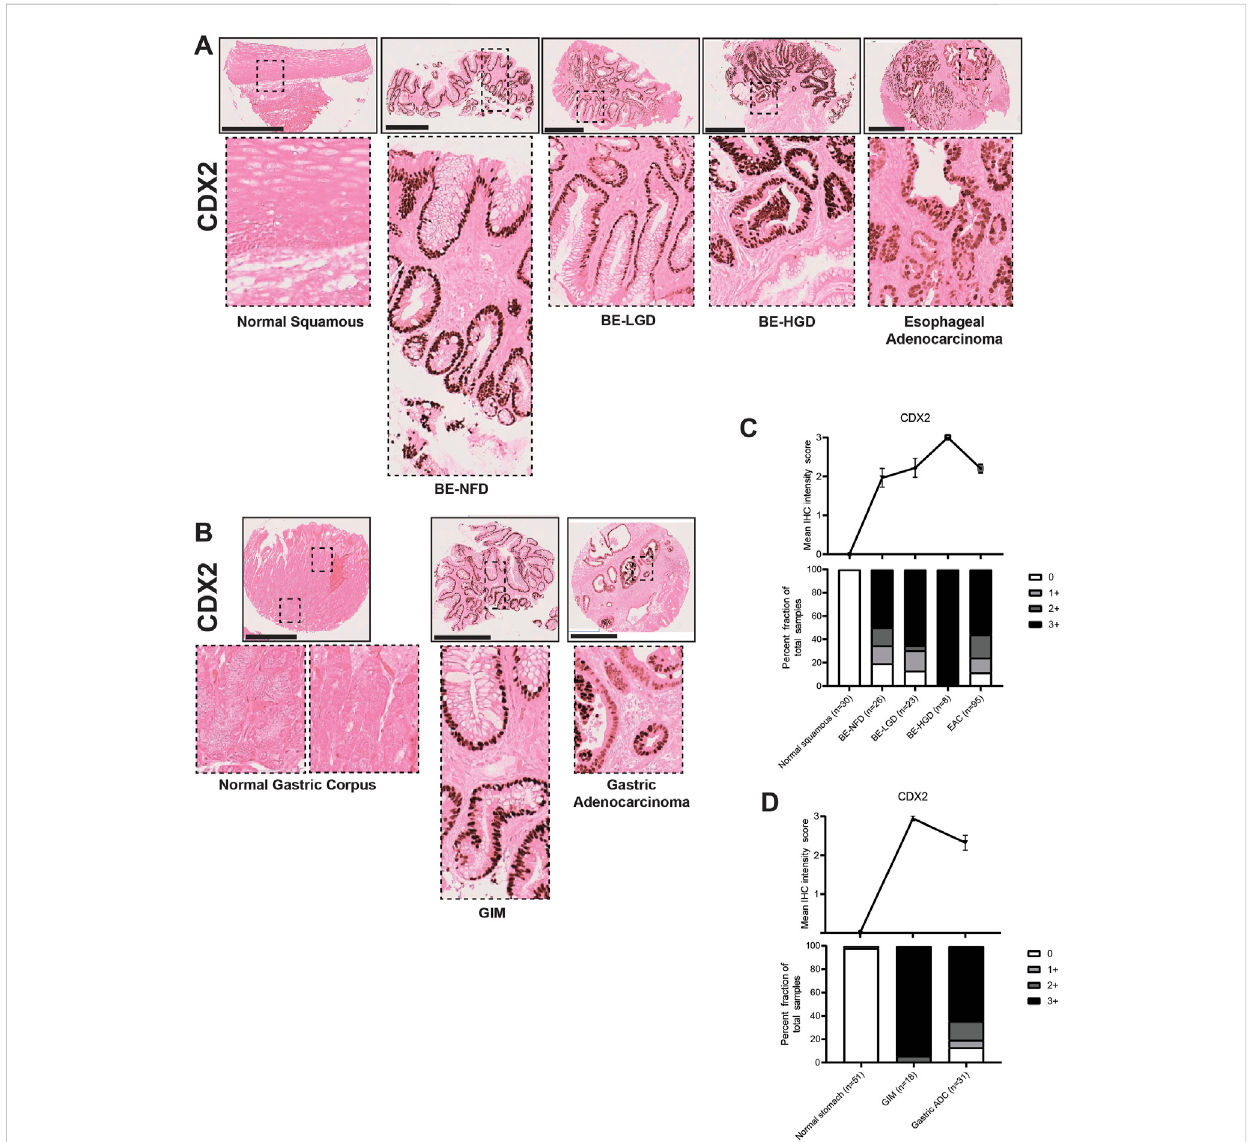
FIGURE 7 CDX2 expression in normal squamous-BE-EAC and normal gastric gland-GIM-GA progression sequence. (A) Immunohistochemistry of